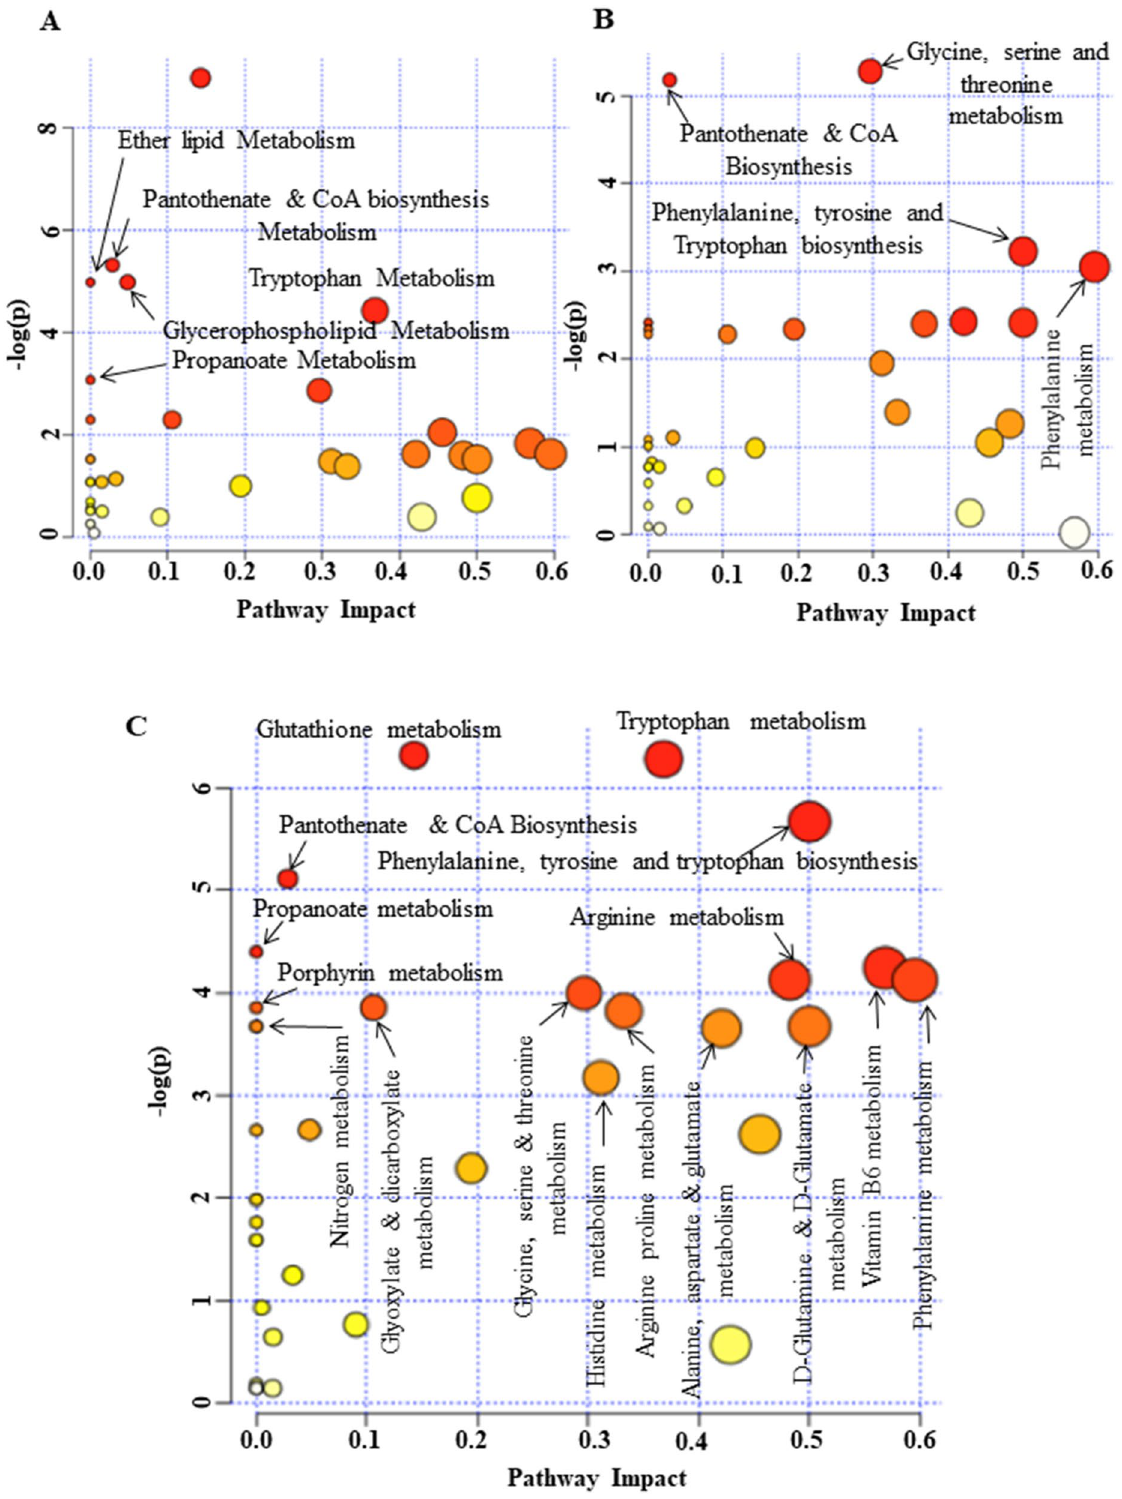
Figure 4. Summary of pathway analysis with Ingenuity pathway analysis based on KEGG database. All the significantly match ( p value < 0.05) were labeled. The color and size of each circle was based on p value and pathway impact value, respectively. Pathways that were significantly altered between ( A ) proliferating myoblasts (Day 0) and early differentiating culture (Day 2), ( B ) proliferating (Day 0) and late differentiating culture (Day 4), and ( C ) early and late differentiating